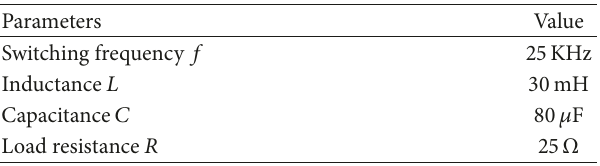
Table 6: Operating values for boost